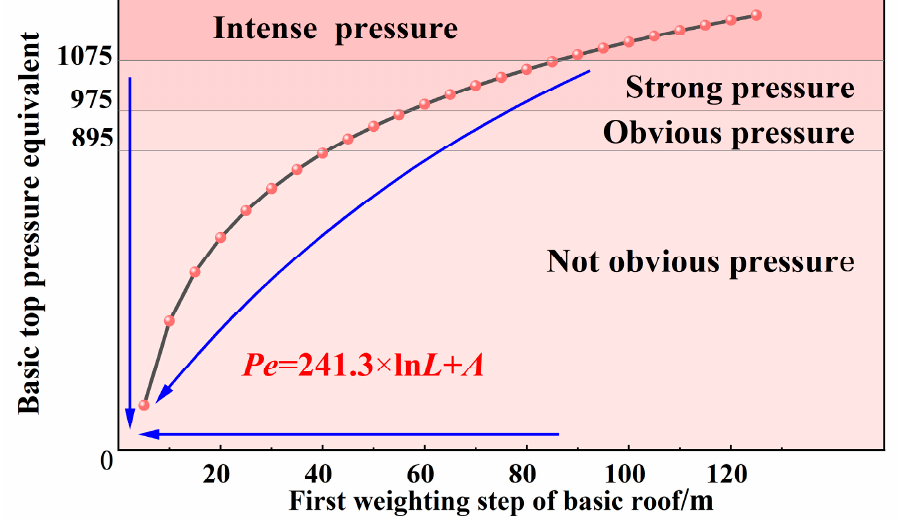
Figure 1. Relationship curve between P e and L. Through the analysis of influencing factors of mine pressure in a thick and hard roof stope, it is concluded that the mine pressure strength of a directly covered thick and hard roof working face depends on the breaking step of a thick and hard basic roof and the size of the stope. It is difficult for the thick, hard roof to immediately collapse under its own weight after the coal seam has been mined. Industry experts say that the length of the cantilever that the roof creates in the goaf and the size of the breaking step are both related to the thickness of the roof. The risk of ground pressure in the working face also increases noticeably due to the impact force produced by the movement of the thick, hard roof. A directly covered thick and hard roof leads to a large range of rock pressure in the working face, and a large impact load when unstable.